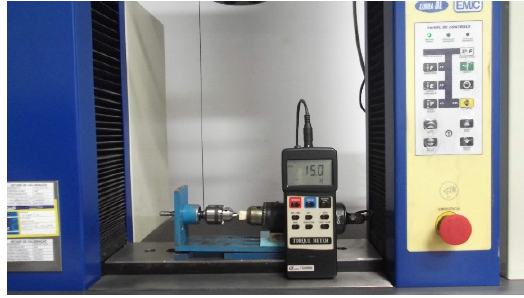
Figure 1. The set up used for insertion and remove screws torque test.